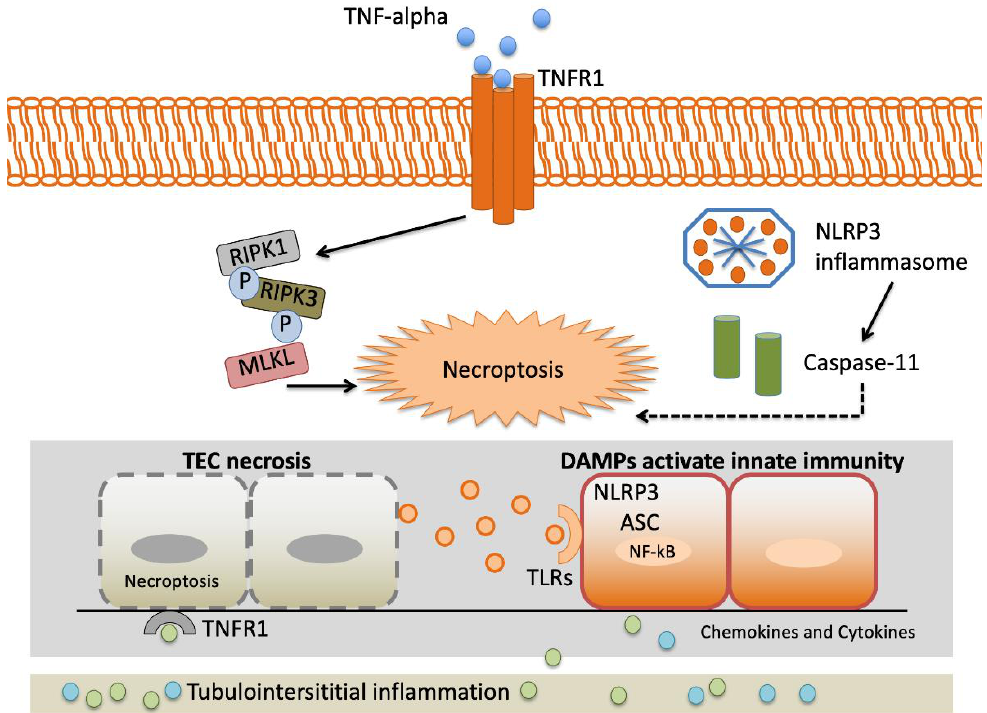
Figure 2. Landscape of interstitial inflammation caused by TNF- α . Complexity of the TNF- α signaling system. TNFR1 signaling results in both activation of proinflammatory pathways and necroptosis triggered by the RIPK3-MLKL system. The NLRP3 inflammasome is a crucial element of the innate immune system that favors caspase activation and the production of proinflammatory cytokines due to damage-associated molecular patterns (DAMPs). Abbreviations: Apoptosis-associated speck-like protein containing a caspase recruitment domain (ASC). Damage-associated molecular patterns (DAMPs). Leucine-rich repeat-containing protein 3 (NLRP3). Mixed-lineage kinase domain-like (MLKL). Nuclear factor-kappa light-chain enhancer of activated B cells (NF- κ B). Receptor interacting protein kinase-1 (RIPK1). Receptor interacting protein kinase-3 (RIPK3). Tubular epithelial cell (TEC). TNF receptor 1 (TNFR1). Toll-like receptor